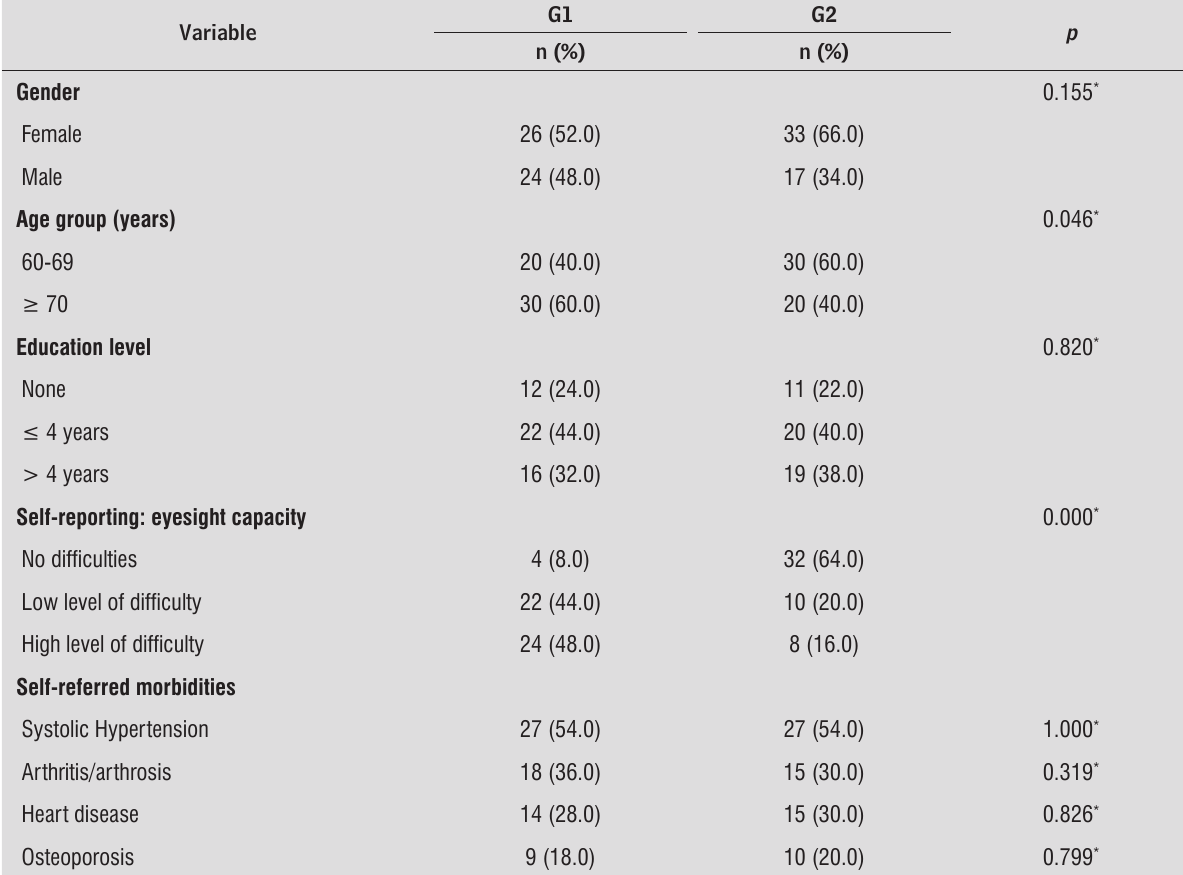
Table 1 - Contextual factors for the elderly from G1 and